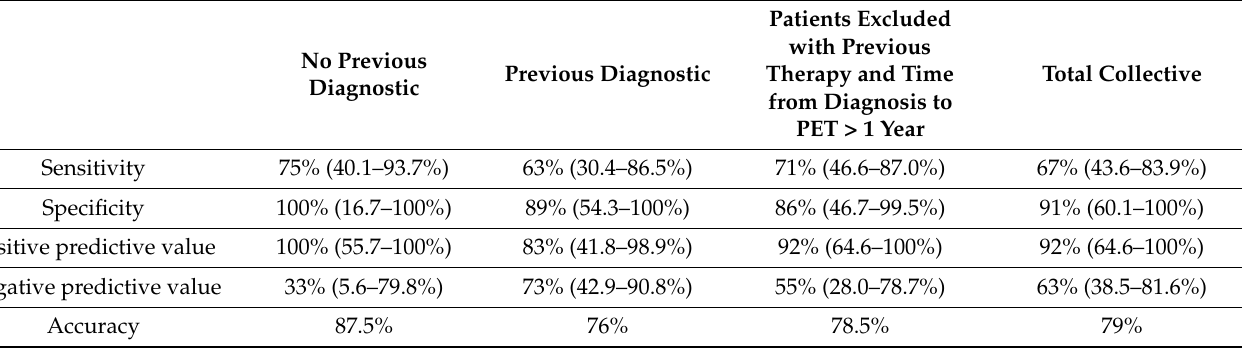
Table 3. PET/CT with regard to previous diagnostic and